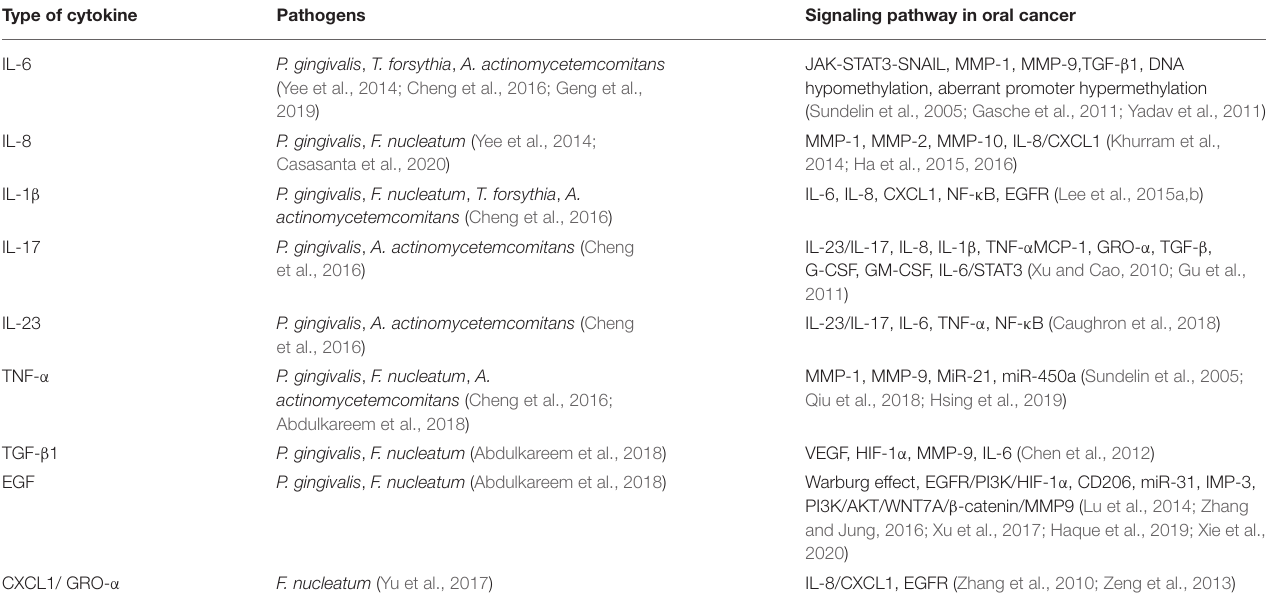
TABLE 2 | List of some cytokines secreting by periodontal pathogens stimulation, the role of which in periodontitis and oral cancer and the signaling pathways involved in oral cancer. Type of